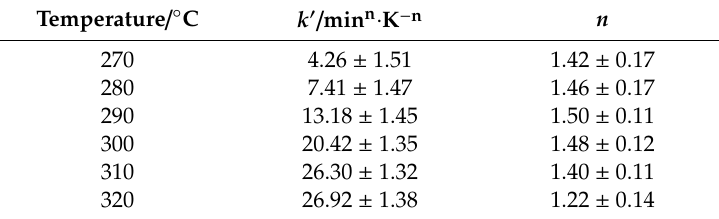
Table 3. Kinetic parameters obtained from Equation (9) at different temperatures under dynamic conditions for the 4, 8, and 10 wt% systems.